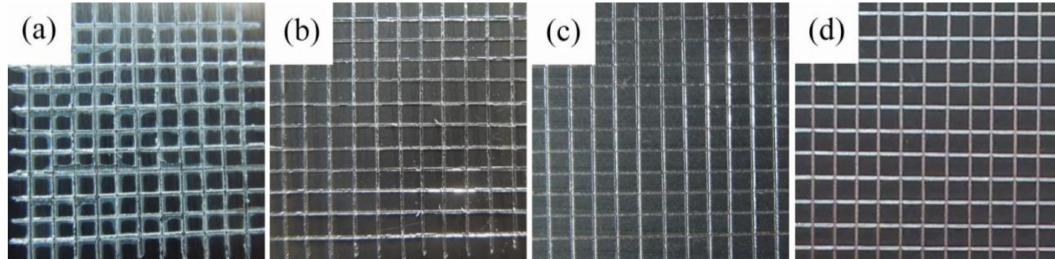
Figure 8. Appearance of cross-cut surface before application of tape: ( a ) PU, ( b ) PU2, ( c ) PU4 and ( d )